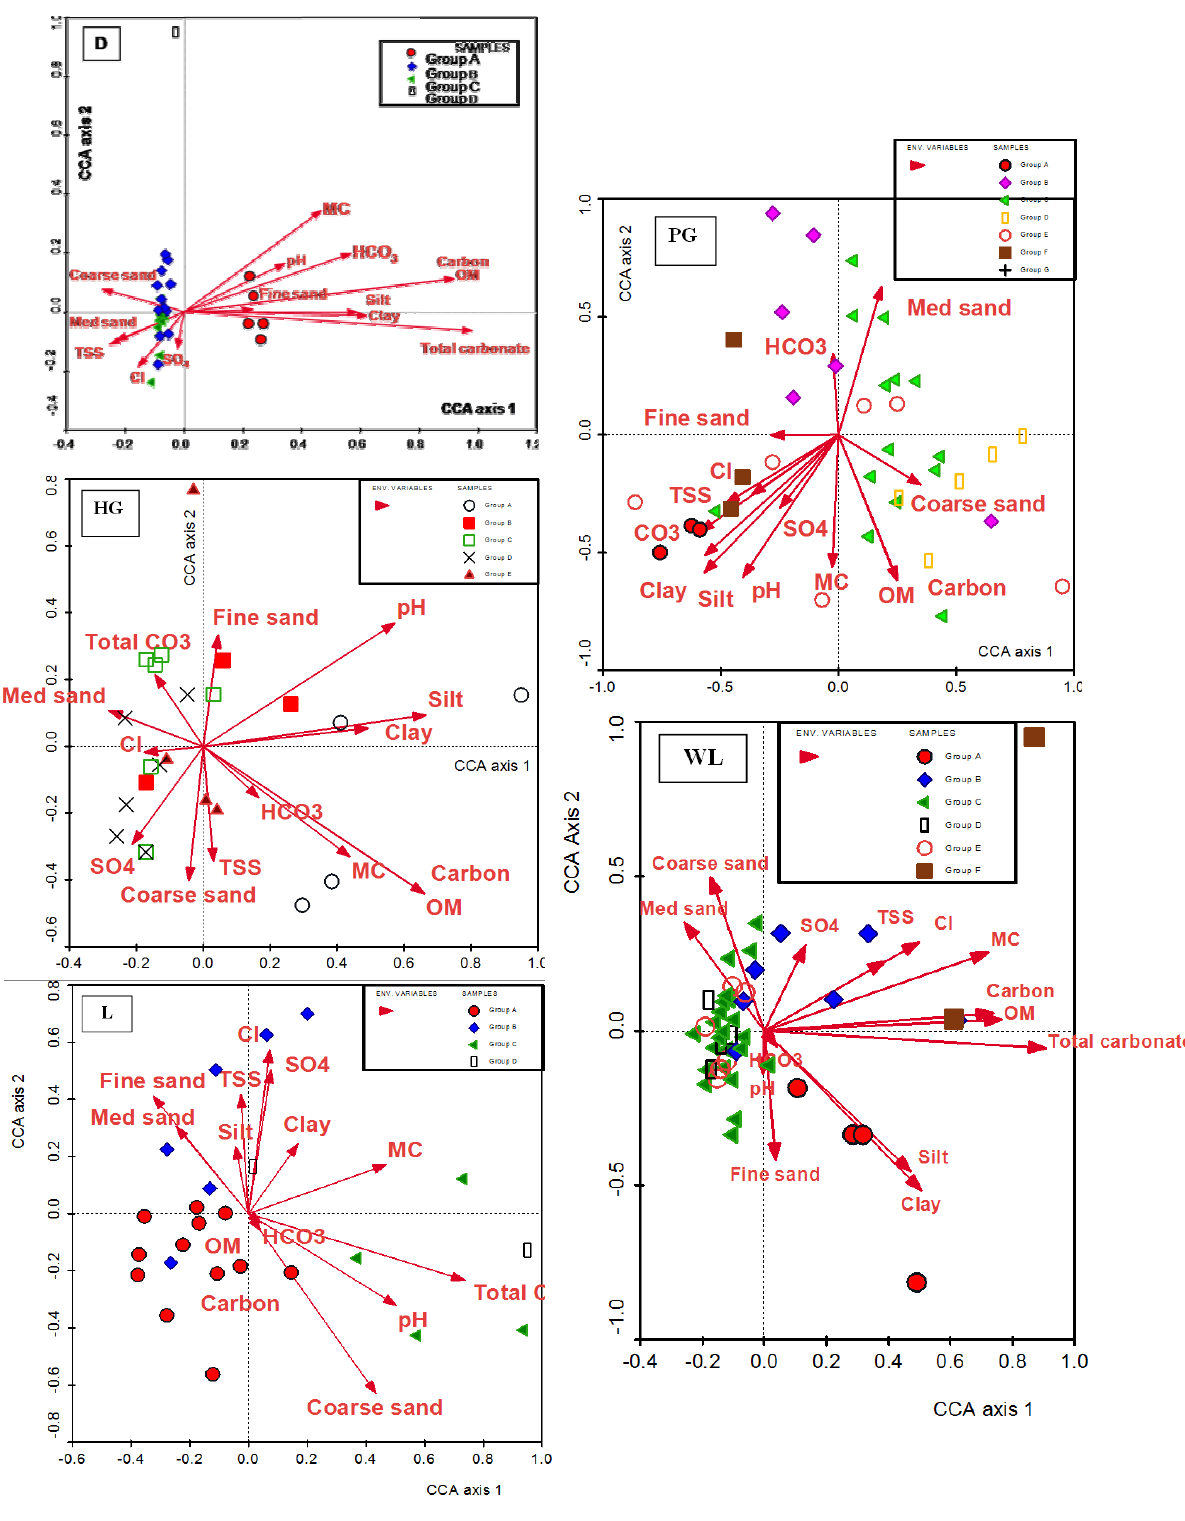
Fig. 3. CCA biplots of axes 1 and 2 showing the distribution of stands of the habitats, together with their Twinspan groups and soil variables; D=Desert, HG=Home gardens, L=Lawns, WL=Waste lands and PG=Public